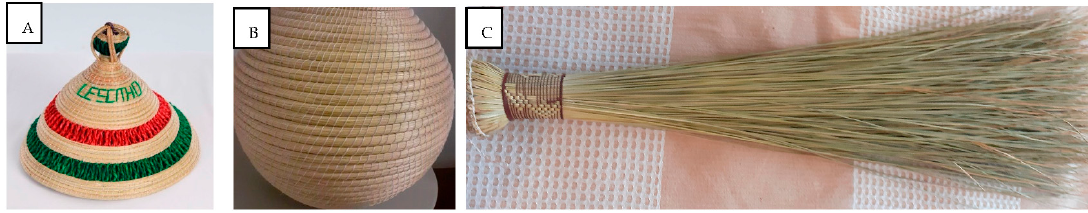
Figure 4. Some of the crafts produced from Merxmuellera spp.–a traditional Basotho hat ( A ), basket ( B ) and broom ( C ); source (L. Seleteng-Kose). Table 1. A summary of commercially important plants of Lesotho, their biological activity and conservation statuses.